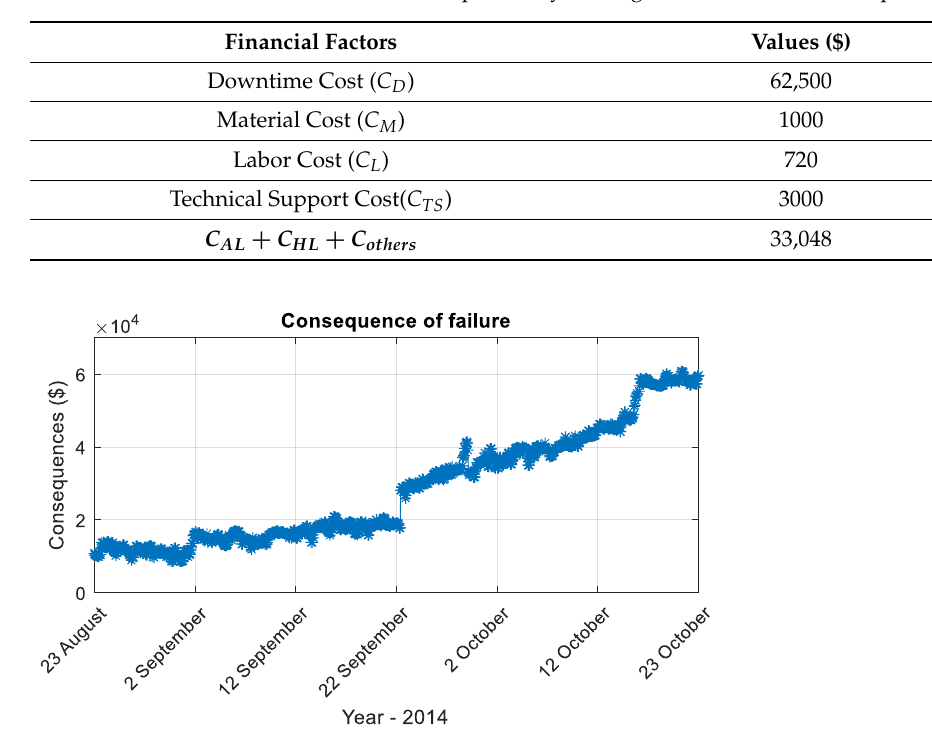
Figure 19. Consequence of a fault that happened in the compressor.